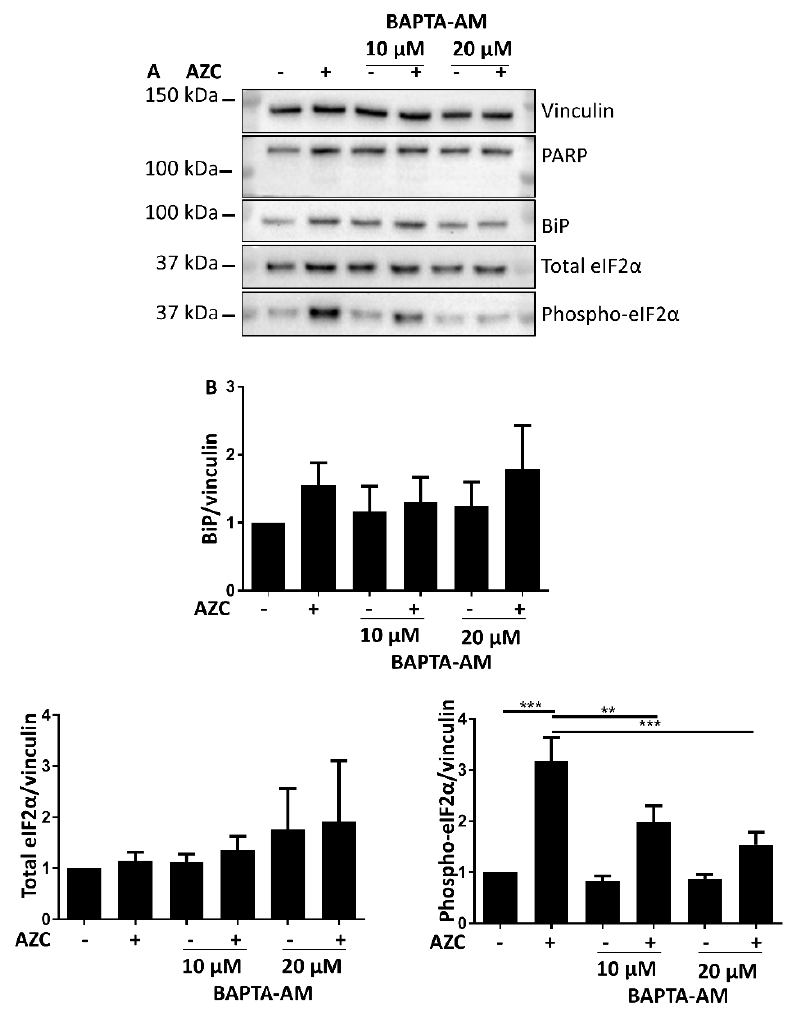
Figure 6. AZC-induced elevation of phospho-eIF2 α levels is Ca 2+ dependent. Cells were treated for 6 h with 5 mM AZC in absence or presence of 10 µ M or 20 µ M of the intracellular Ca 2+ chelator BAPTA-AM and during the last 4 h 100 nM Baf A1 was added. ( A ) Representative blot of six independent experiments each performed in duplicate showing protein levels of the cell death marker PARP, and of ER stress markers BiP, total eIF2 α and phospho-eIF2 α . Vinculin was used as loading control. ( B ) Quantification of ER stress markers in ( A ) shown as mean ± SEM relative to untreated control. ** p < 0.01, *** p < 0.001.